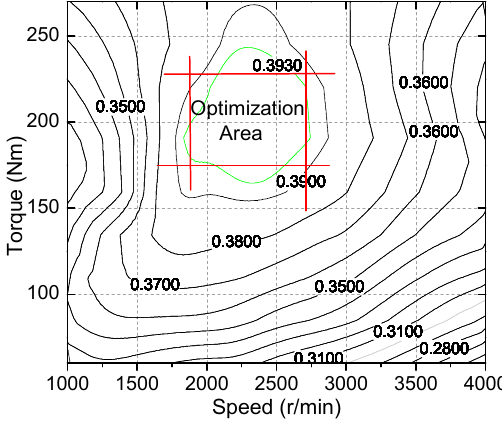
Figure 3. Engine efficiency map.